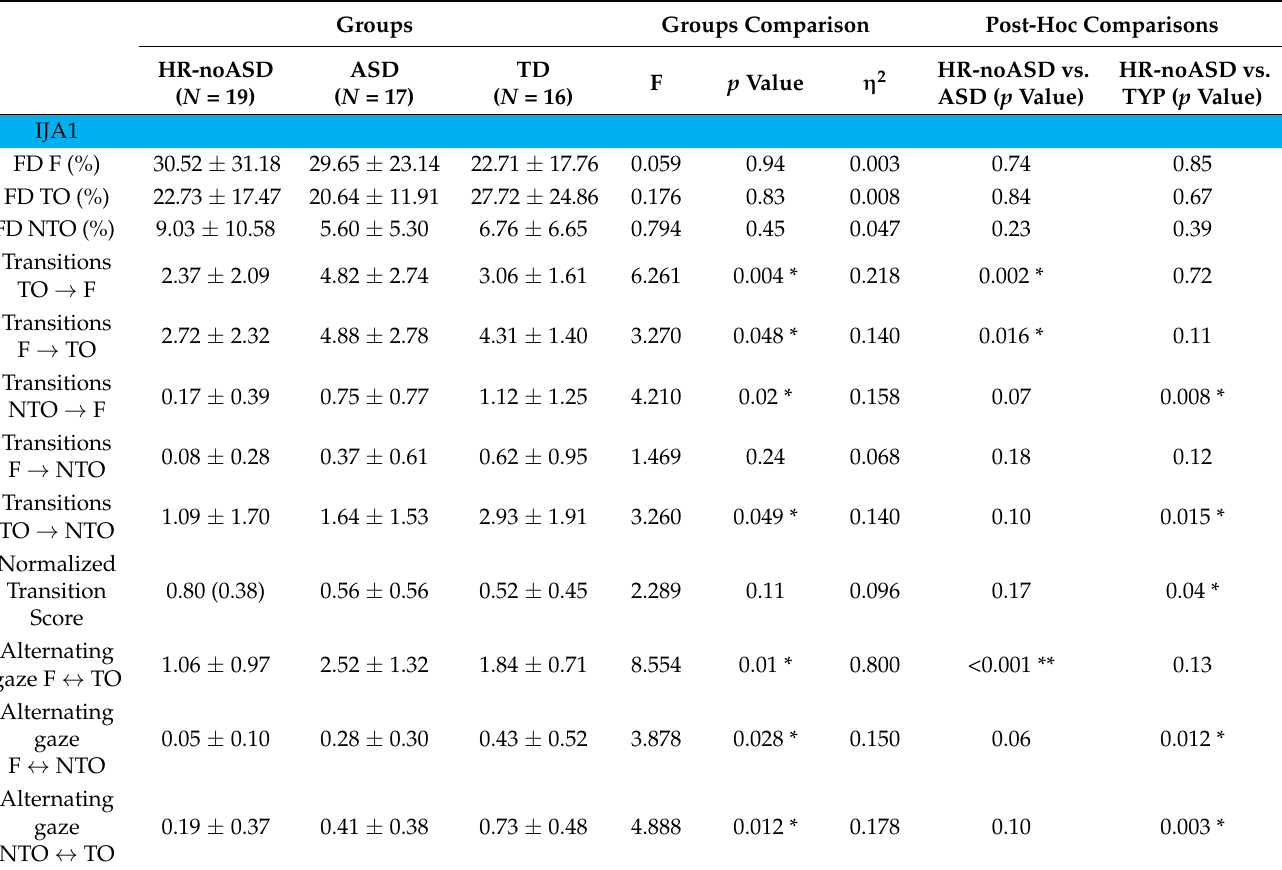
Table 2. Transitions, alternating gaze and fixation for the joint attention phase of the IJA-1. Groups Groups Comparison Post-Hoc Comparisons